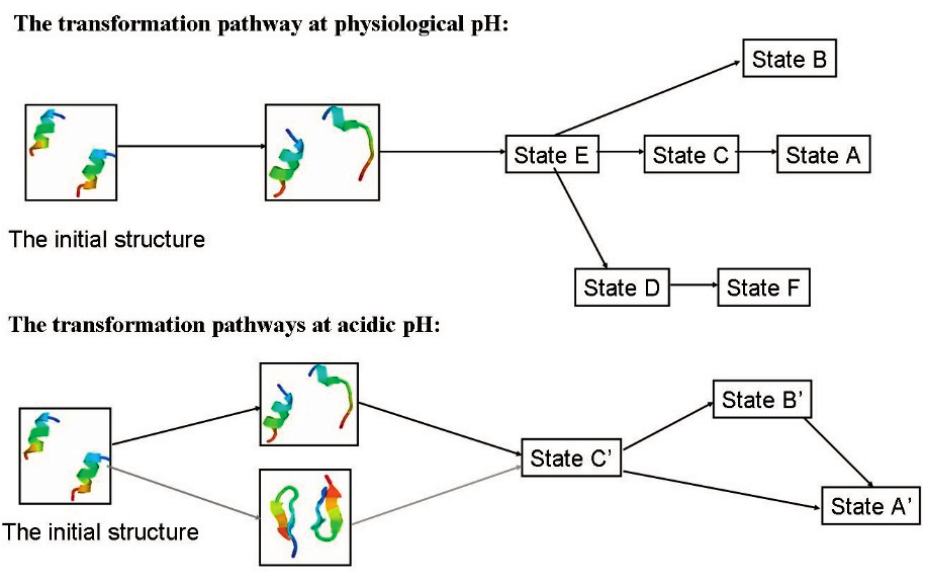
Figure 4. The possible transformation